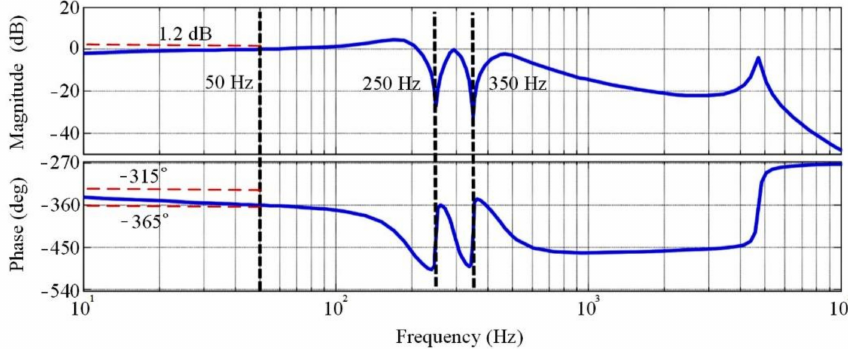
Figure 6. Bode diagram of G ( s )